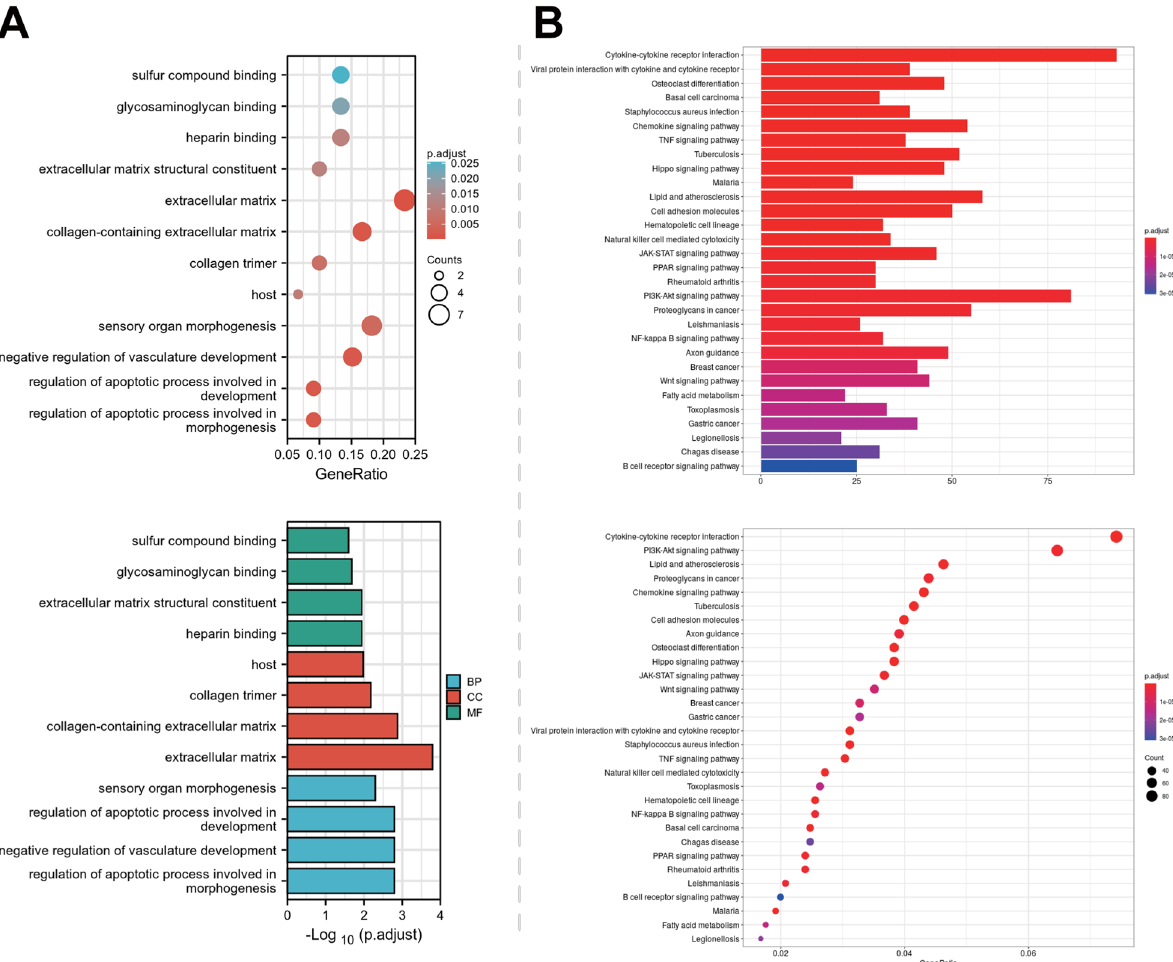
Fig. 3 Functional enrichment analysis of candidate genes involved in the IDD in DM. A Histogram and bubble chart of GO function analysis of 35 candidate DEGs at the levels of BP, CC, and MF. Column color indicates p value, the length of the columns indicates the number of enriched targets, the dot color indicates the p value, and dot size indicates the number of enriched targets. B Histogram, and bubble chart of KEGG pathway enrichment analysis of 35 candidate DEGs. Column color indicates p values, the length of the columns indicates the number of enriched targets, dot color indicates the p value, and dot size indicates the number of enriched